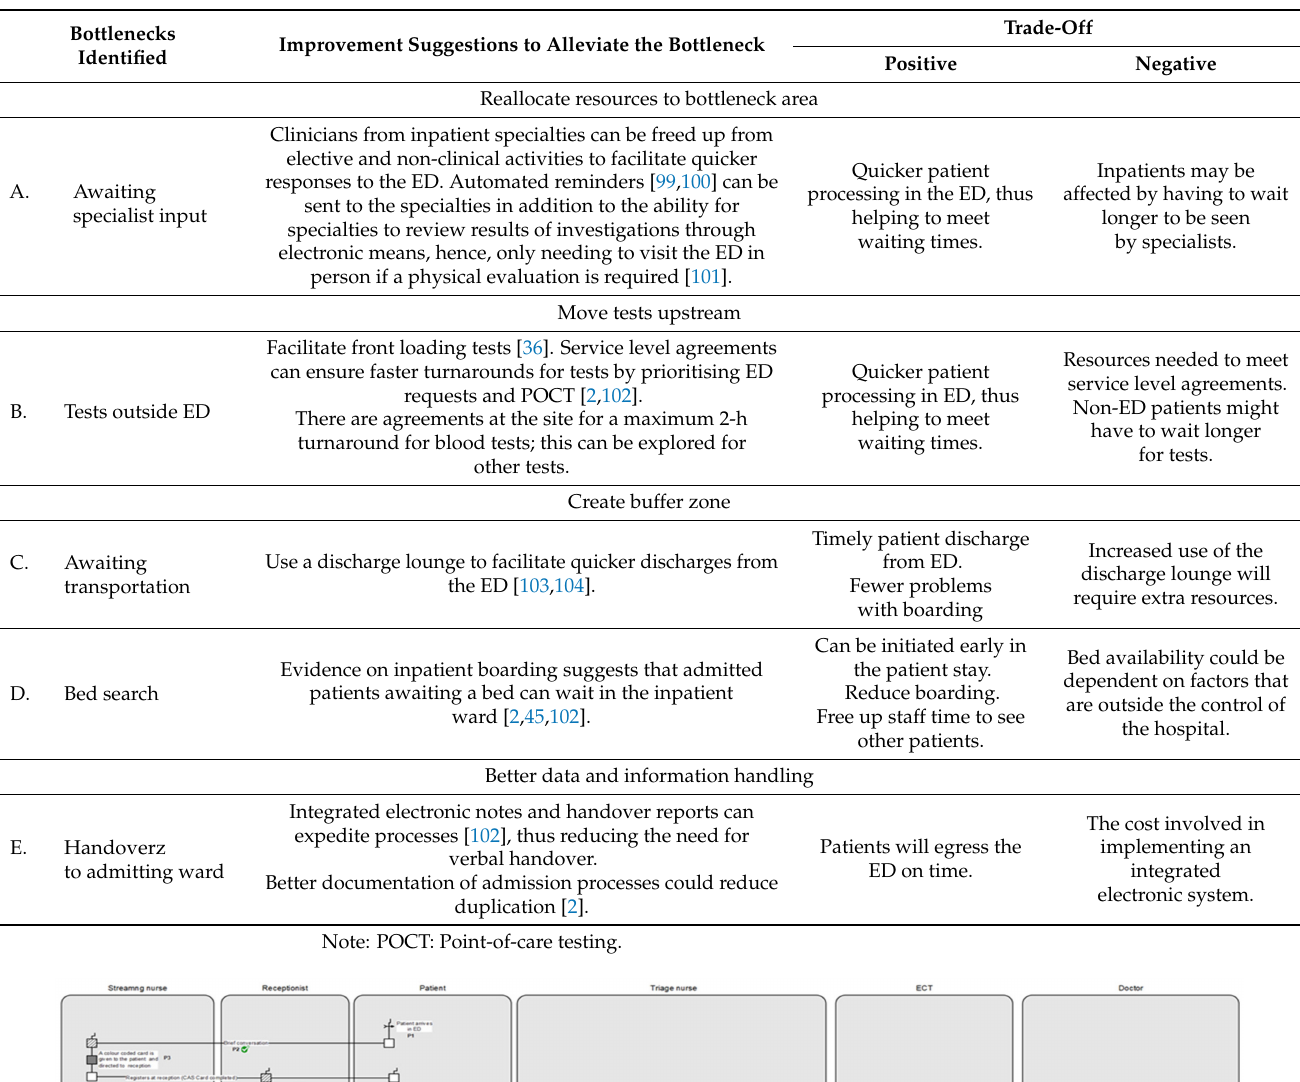
Table 3. Recommendations to manage common bottlenecks in the ED compiled from the literature.